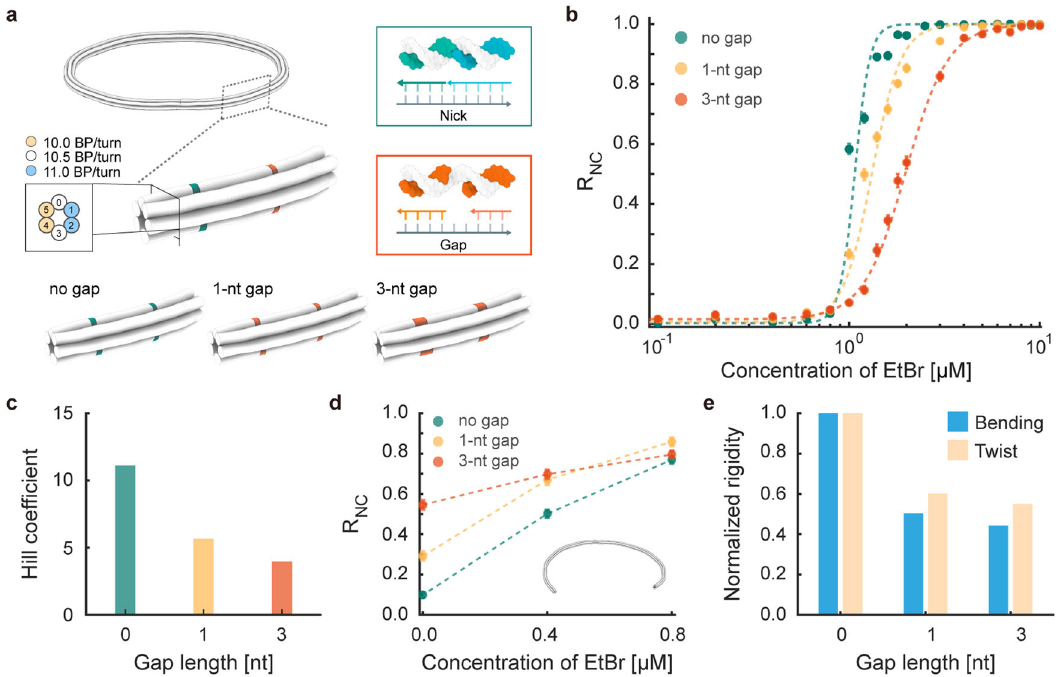
Fig. 3 Sensitivity modulation through stress relaxation by gaps. a 6HB closed rings with gaps. b R NC values as a function of EtBr concentration. Circles and error bars represent the means and the standard deviations of experimentally measured R NC values, respectively. Dashed lines represent the fi tted Hill curves. c Effect of the gap length on the effective Hill coef fi cient. d Effect of gaps on the con fi gurational change of 6HB open rings. e Effect of gaps on the mechanical properties of straight 6HB